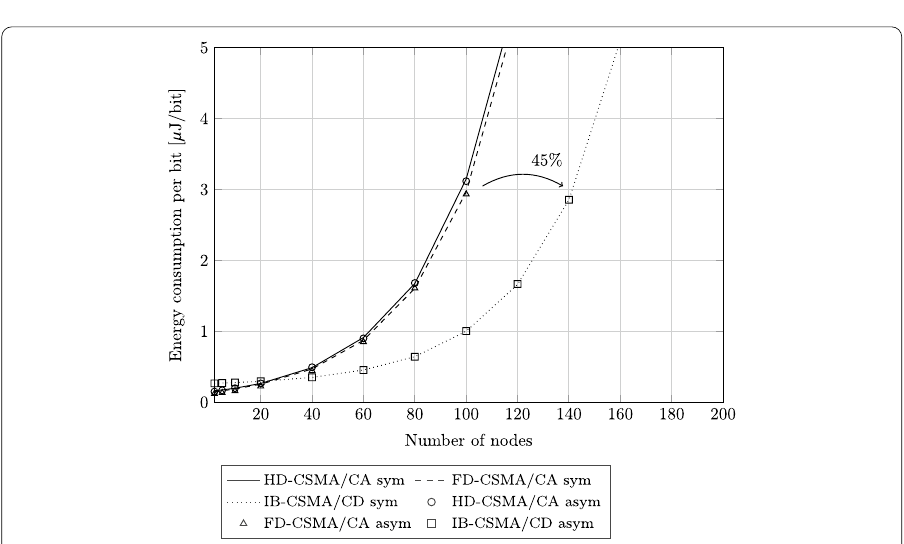
Fig. 11 Saturated scenarios (1&2): The average energy consumption with no interference in saturated traffic conditions shows that IB-CSMA/CD is more energy efficient if more than 20 nodes are in the network compared to HD-CSMA/CA and